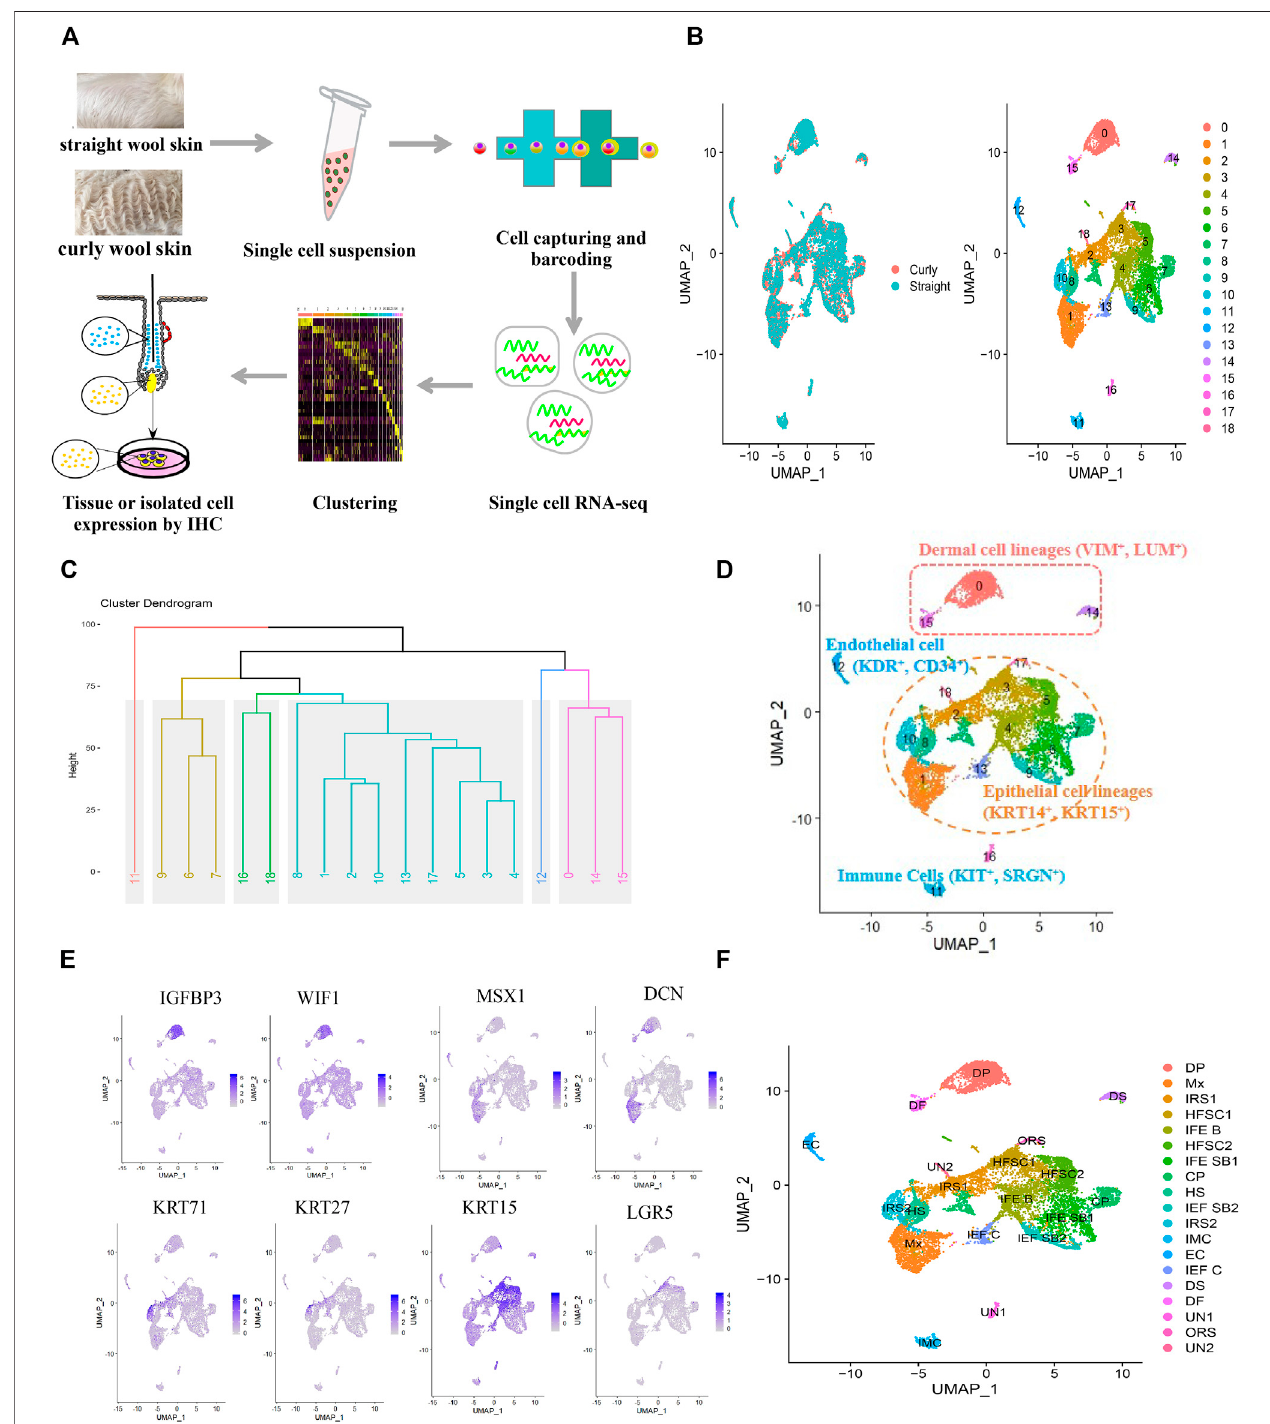
FIGURE 1 | Single-cell sequencing and characterization of cellular heterogeneity of sheep lambskin. (A) Overview of the experimental work fl ow. (B) UMAP plot of sheep lambskin single skin cells. The left plot depicts UMAP plot of the integrated dataset from two different groups including straight wool and curly wool groups, and cells are different color-coded. The right plot depicts 19 transcriptional distinct cell clusters, and cells are color-coded with cluster information. Cells in the same cluster represent high similarity in transcriptome pro fi le. (C) Hierarchical clustering on the 19 cell clusters. Six major branches with different color are revealed. (D) Characterization of major cell types in the sheep lambskin tissues in the UAMP plot. Cells are color-coded and are labeled with their cell identity. (E) Feature plot depicts representative gene expression of dermal cell, matrix, and HFSC. (F) Annotation of each cell cluster in the UAMP plot.